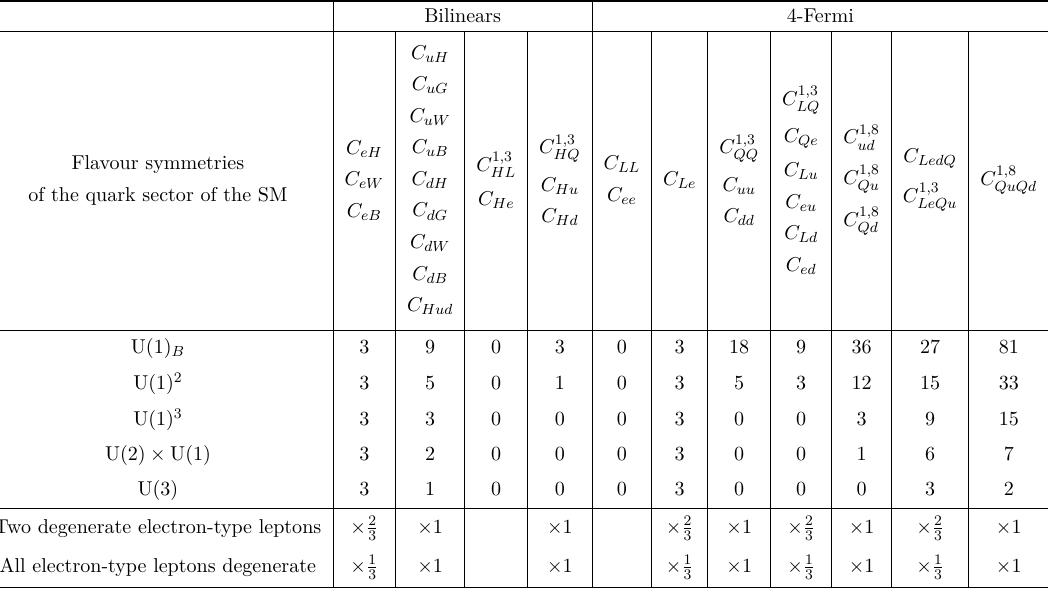
Table 4 . Numbers of new primary sources of CPV contained in each dimension-six SMEFT coefficient, for each of the possible flavor groups of the quark sector of the SM 4 at dimension-4 (restricting to situations where fermion masses are non-vanishing). The last two rows indicate which multiplicative coefficient should be applied to all numbers of the same column for special values of the electron-type lepton